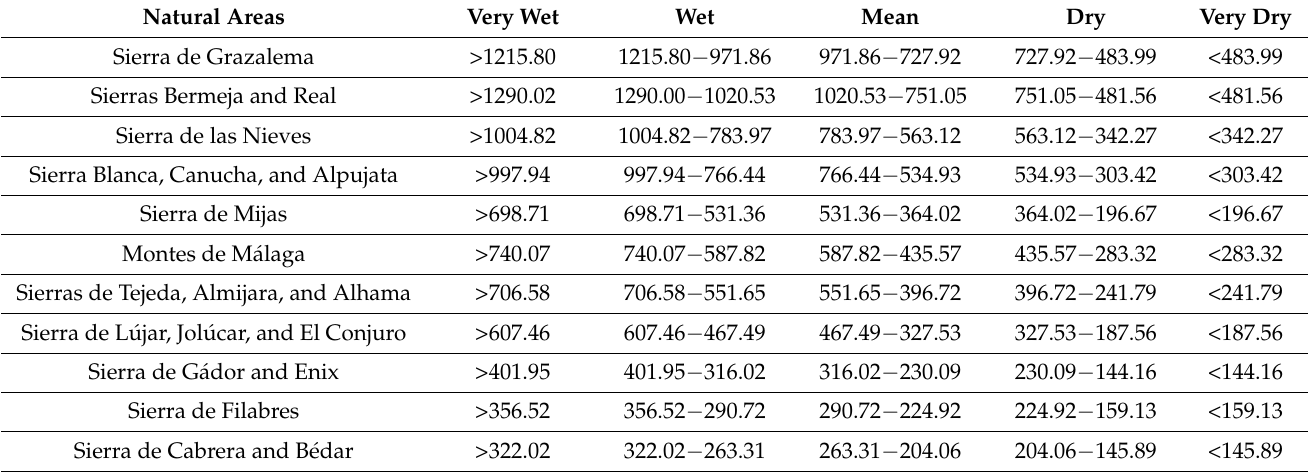
Table 4. Time series (1997–2021). Criteria for category assignment: precipitation volume (L/m 2